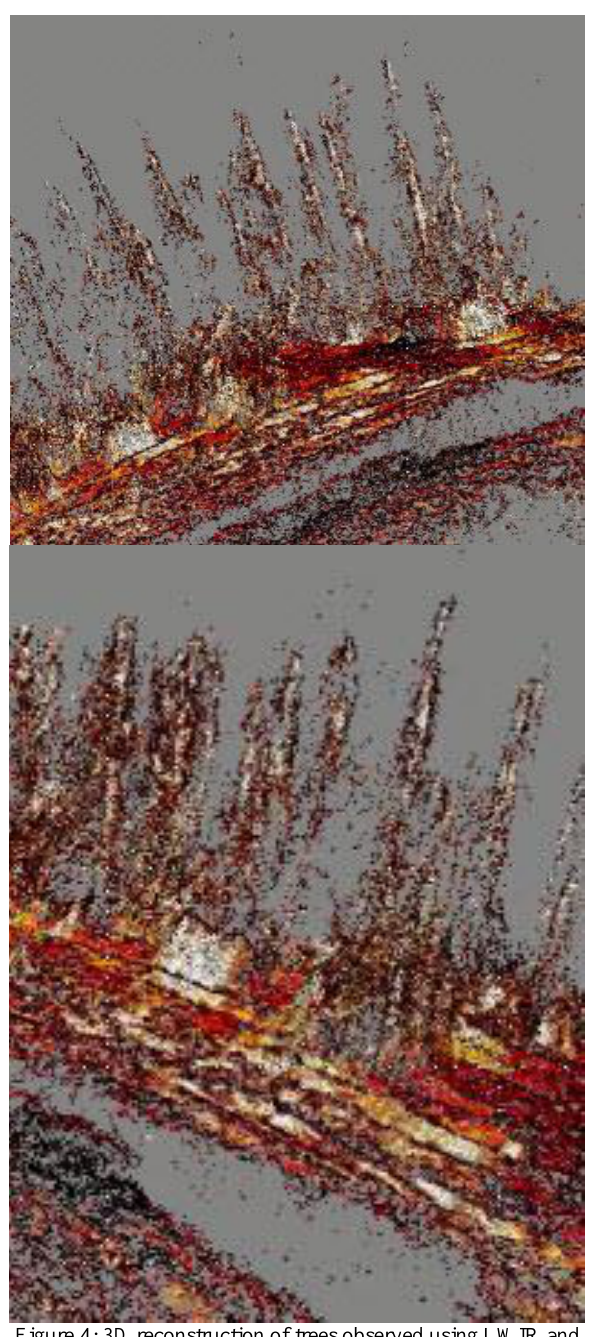
Figure 4: 3D reconstruction of trees observed using LWIR and BIV pre-conditioning with SfM obtained using Agisoft software